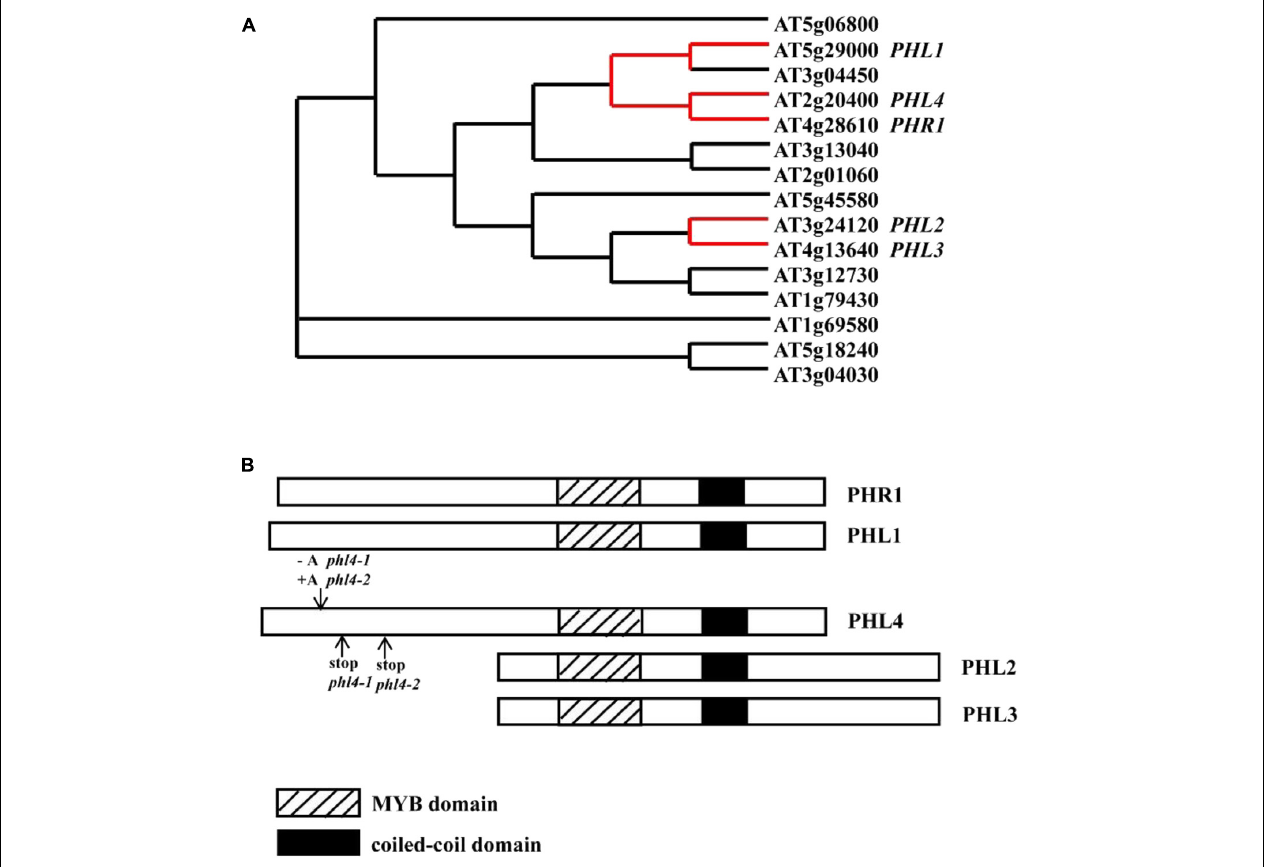
FIGURE 1 | The relative position of PHL4 in the MYB-CC protein family and the mutations in two phl4 mutant alleles. (A) The phylogenetic tree of MYB-CC protein family was generated by an online service 1 . The red lines indicate the positions of PHR1 , PHL1 , PHL2 , PHL3 , and PHL4 in the tree. (B) Alignment of protein sequences of PHR1, PHL1, PHL2, PHL3, and PHL4. The downward arrow indicated the position where a nucleotide “A” was inserted or deleted due to the gene editing. The upward arrows indicated the positions where the premature stop codon was generated in two mutant alleles. Note that although a similar